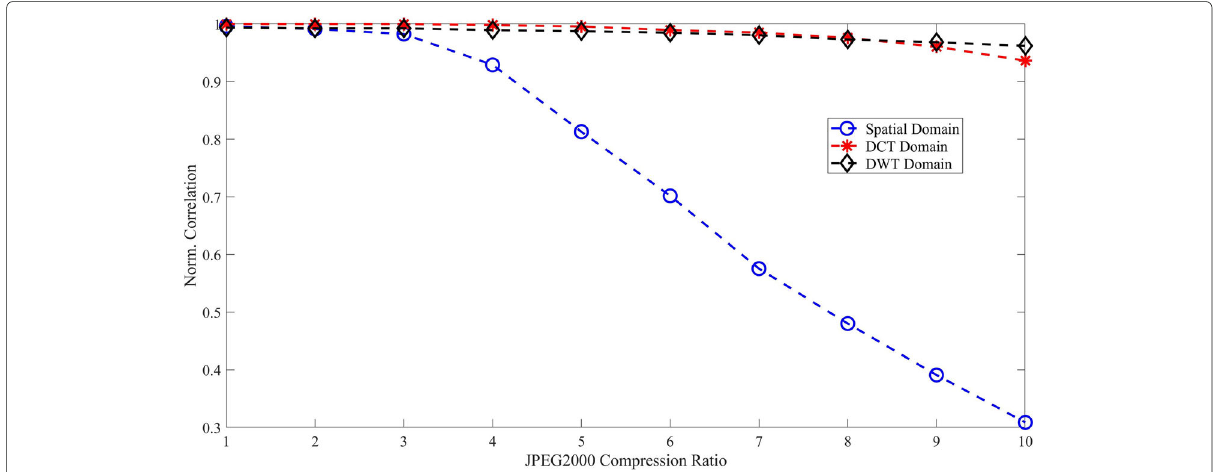
Fig. 11 Correlation value versus JPEG2000 compression ratio in three investigated domains (averaged over 50 images)